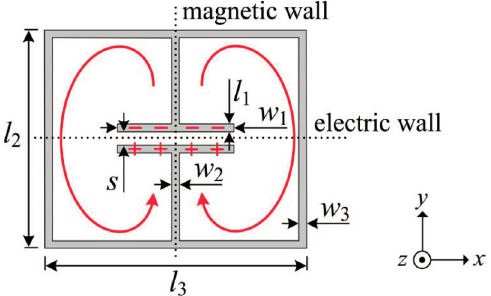
Figure 9. Bisymmetric ELC (electric-LC) resonator. The electric and magnetic walls at the fundamental resonance, as well as a sketch of the distribution of charges and currents, are